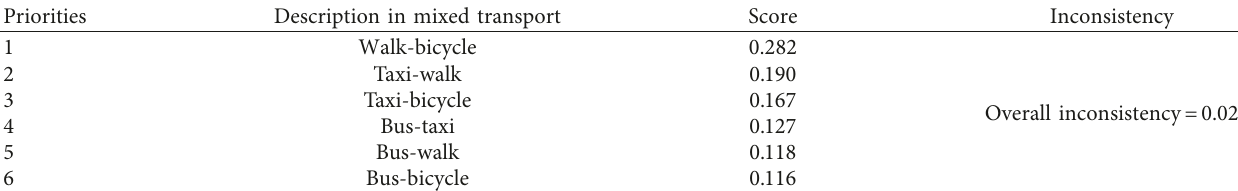
Table 2: The prioritization of options.